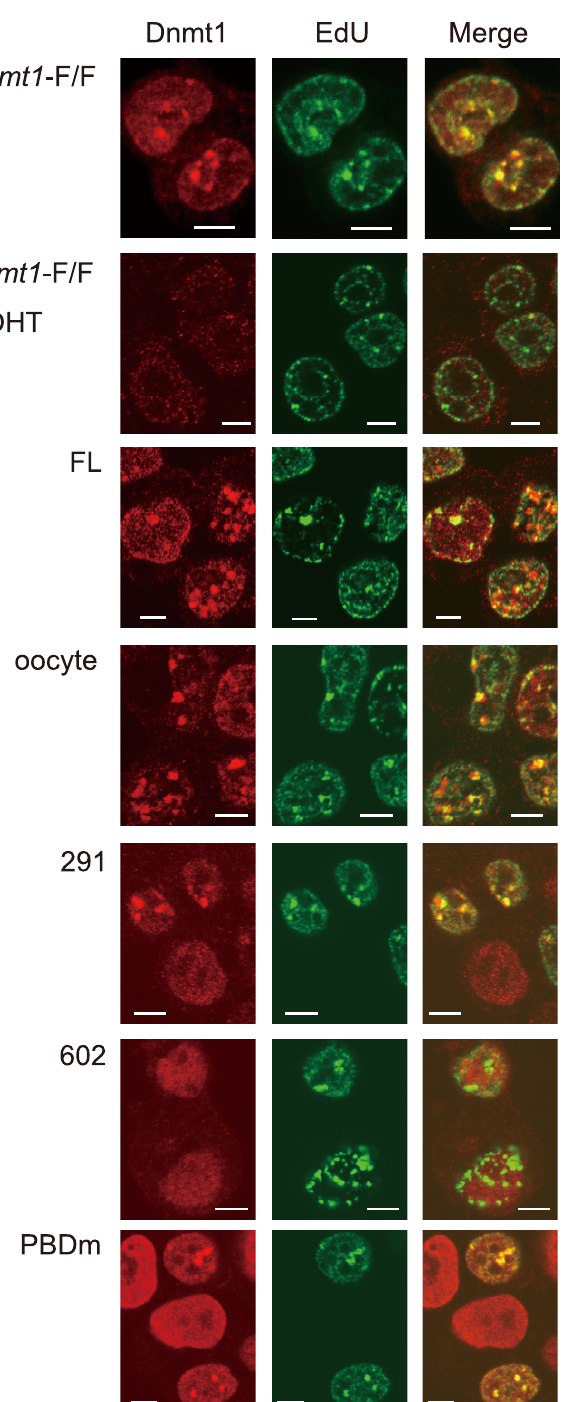
Fig 3. Localization of Dnmt1 at the replication region in ESC. ESC ( Dnmt1 -F/F), and ESC expressing no Dnmt1 ( Dnmt1 -F/F +OHT), or ectopic full-length Dnmt1 (FL), oocyte-type Dnmt1 (oocyte), Dnmt1(291 – 1620) (291), Dnmt1(602 – 1620) (602), or full-length Dnmt1 with the mutation of H168R (PBDm) treated with OHT were labeled with EdU, and detected the EdU (green) and Dnmt1 (red), and the images were merged. White bars indicate 5 μ